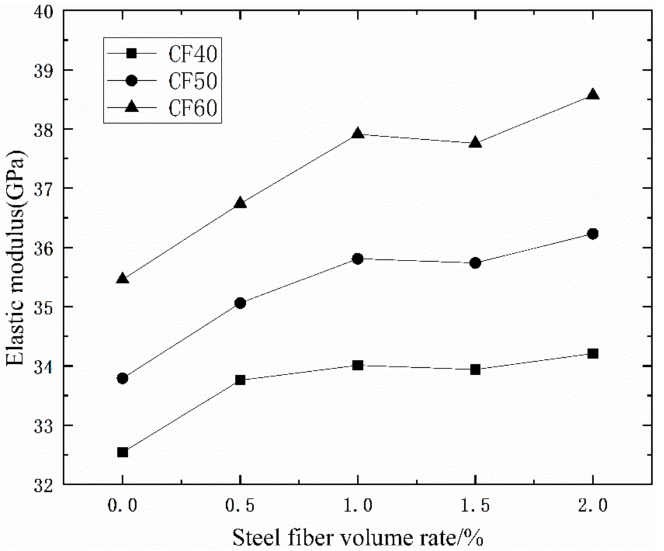
Figure 7. The relationship between the elastic modulus of concrete and steel fiber content.